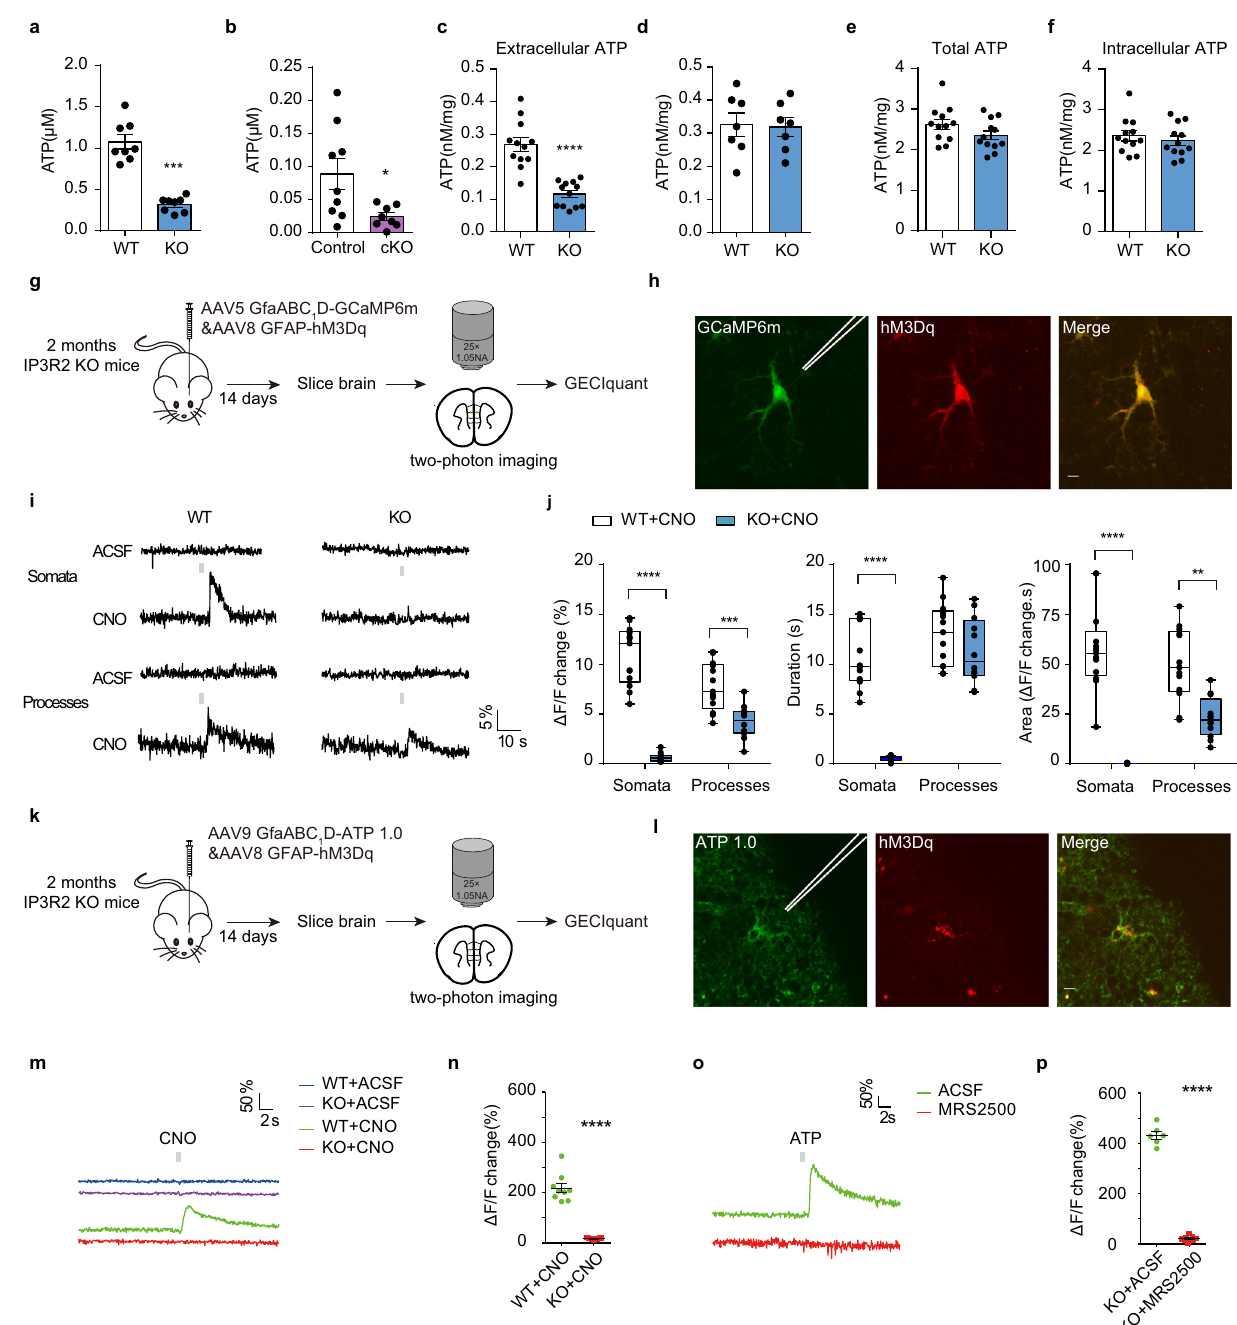
on peripheral tissues. The effects of ATP and ATP γ S on repetitive ATP γ S rescued social impairments but not repetitive behaviors in